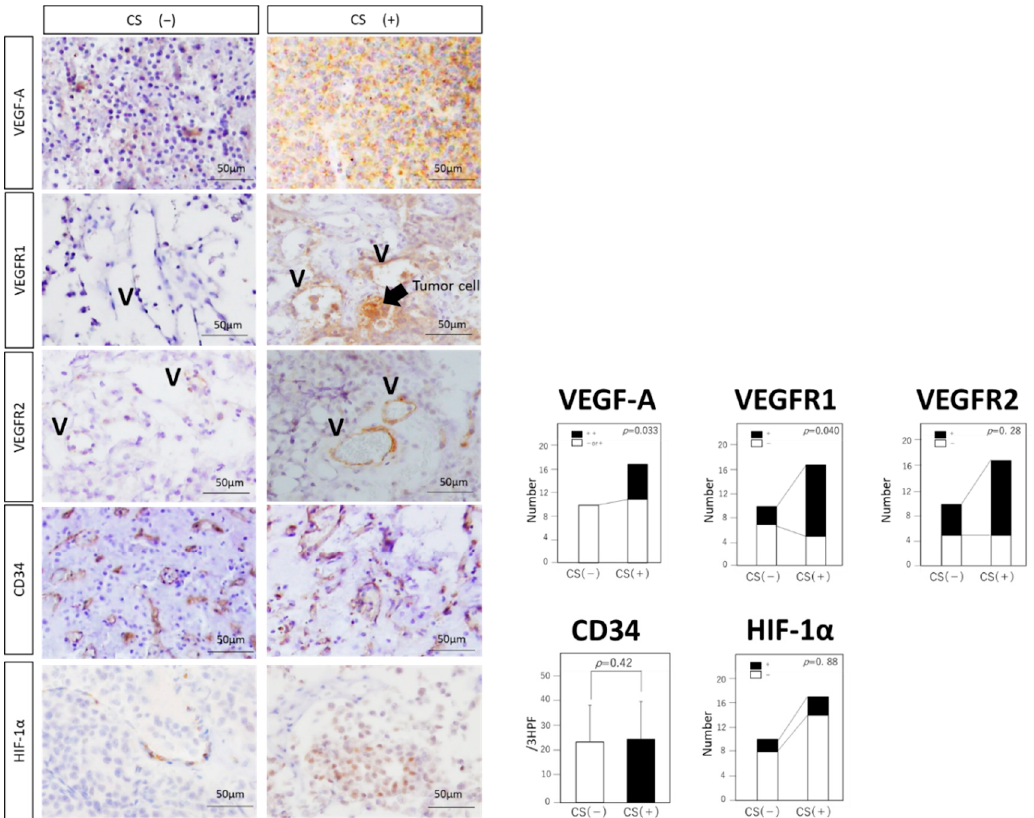
Figure 2. Expressions of VEGF-A related molecules in NF-PitNETs. Immunohistochemical analysis of VEGF-A, VEGFR1, VEGFR2, CD34, and HIF-1. Typical examples of each staining are shown in both groups. Black arrow: tumor cells showing positive VEGFR1 expression. V: vascular structure (original magnification, × 20). Statistical analysis of each staining is shown. Expressions of VEGF-A and VEGFR1 are significantly higher in the CS ( + ) group than in the CS ( − ) group (VEGF-A: p = 0.033, VEGFR1: p = 0.040). Expressions of VEGFR2 and HIF-1 α do not reach statistical significance (VEGFR2: p = 0.28, HIF1- α : p = 0.88). MVD shows no significant difference between the two groups ( p = 0.42). Data represent the mean ± standard error of mean (VEGF-A, VEGFR1, VEGFR2 and HIF-1 α , chi-squared test; MVD, student’s t -test).